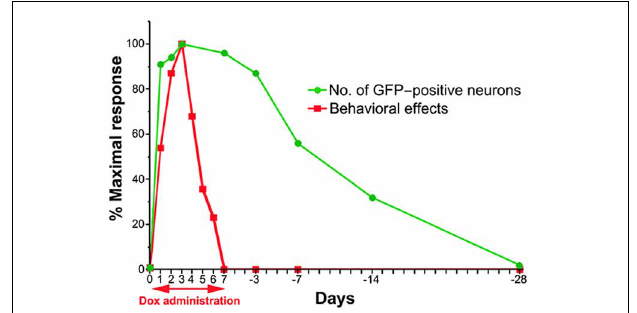
FIGURE 7 | Schematic drawing of the time course for the emergence and disappearance of blocking effects as measured by the behavioral effects and detectability of anti-GFP immunoreactivity after the onset and offset of Dox